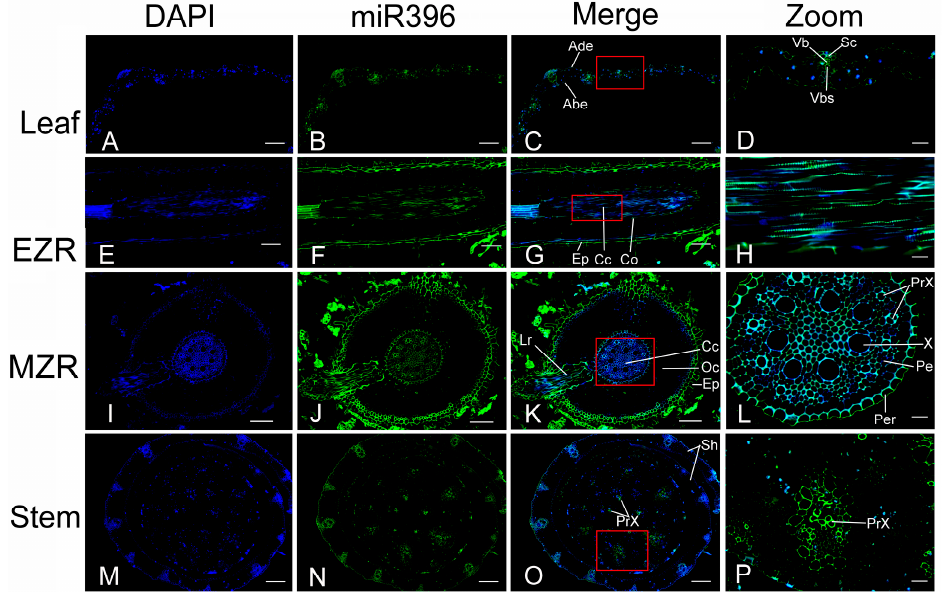
Figure 6. Verification of miR396 location in leaf, root, and internode tissues of the seedlings using FISH. Ped-miR396a-3p was expressed in the vascular tissues ( A – D ) of the leaves, the elongation ( E – H ) and mature zones ( I – L ) of the root tips, and the stems ( M – P ). Abe: abaxial epidermis; Ade: